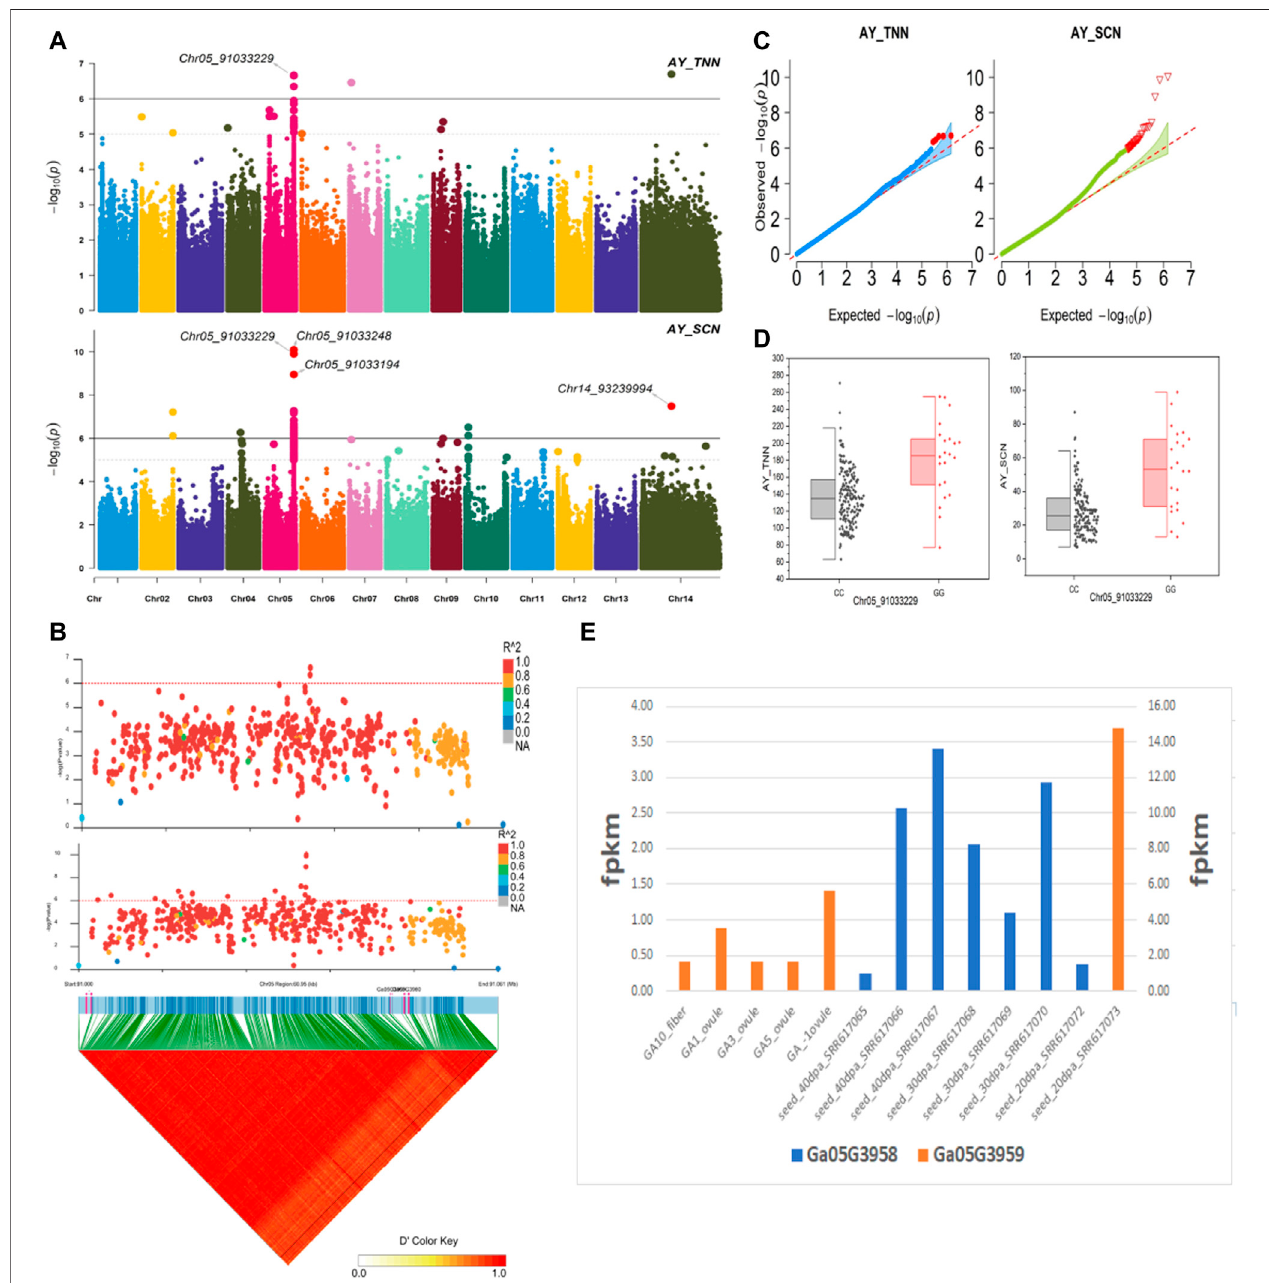
FIGURE5| Genome-wideassociationstudiesforNEPSin G.arboreum (A) ManhattanplotsforNEPsrelatedtraits:AY_TNNandAY_SCN;dotted-horizontallinein each plot depicts signi fi cance threshold value kept at [ − log ( p ) > 6] (B) GWAS-LD block demonstrating haplotype region (60.95 kb) surrounding the displaying peak on chromosome Chr05 associated with NEPs related traits along with GWAS regional plot exposed key SNPs and nearby gene(s) in the region (C) Quantile-Quantile plots for NEPs related traits (D) Box plots revealing differences for NEPs related traits among two favorable haplotypes of SNP Chr05_91033229:AY_TNN (left) and Chr05_91033229:AY_SCN (right) (E) Expression levels of representative annotated genes Ga05G3958 and Ga05G3959 at different developmental stages of G . arboreum .